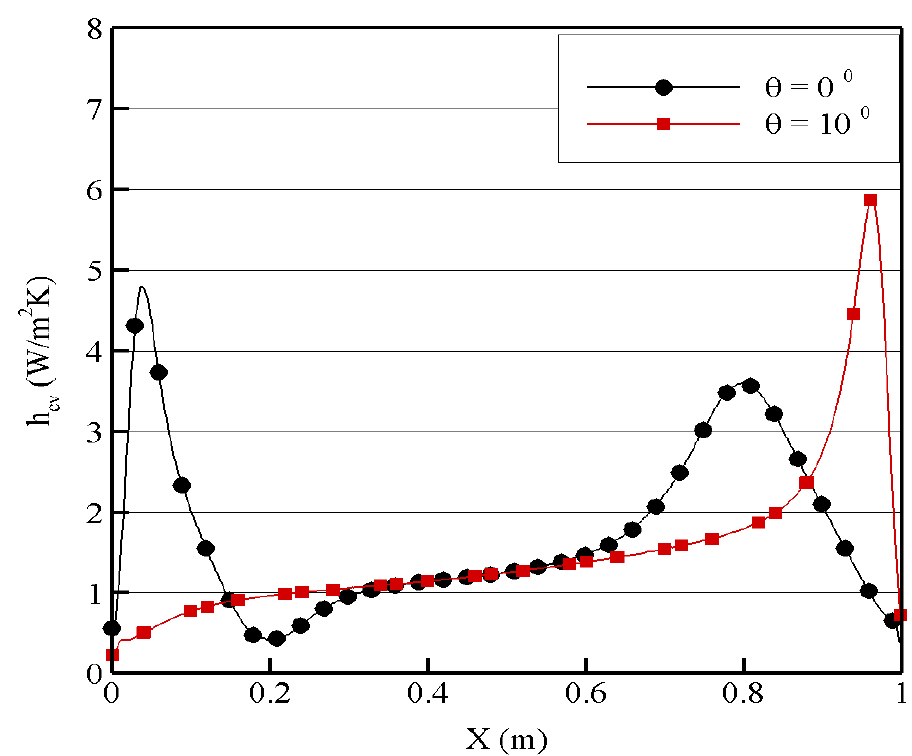
Figure 14. Convective heat transfer coefficient at AR = 5.52; θ = 0°and θ = 10°.